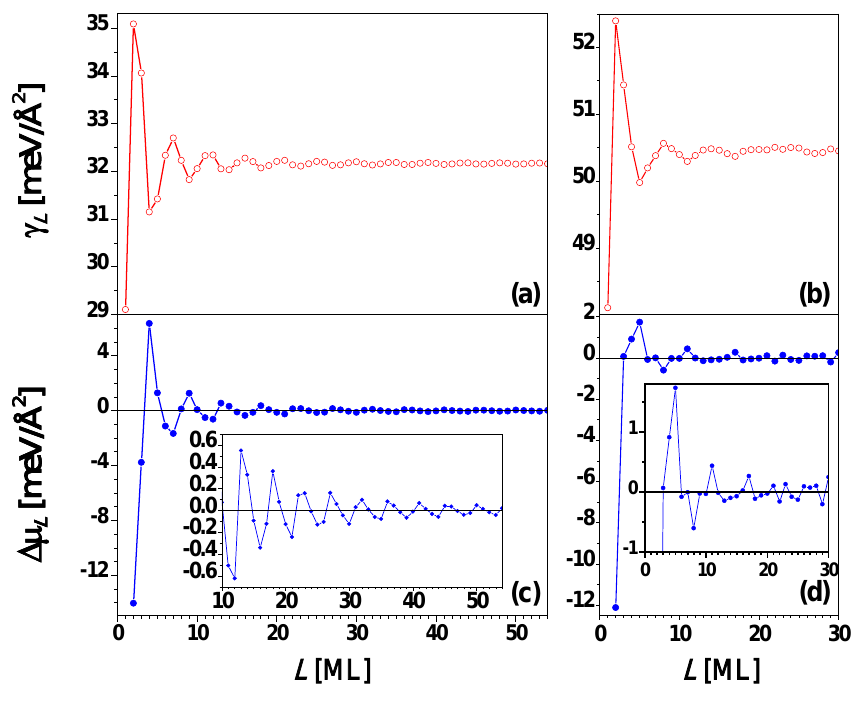
versus thickness L for a freestanding Ag(100) nanofilm Figure 9. Surface free energy γ L from (a) EGM and (b) DFT calculations, respectively. Stability index ∆µ versus L from L (c) EGM and (d) DFT calculations, respectively. The insets are the corresponding local enlargement. From [67] (Copyright American Physical Society